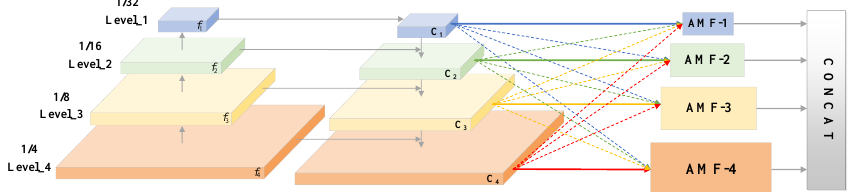
Figure 4. Adaptive multiscale feature fusion framework.